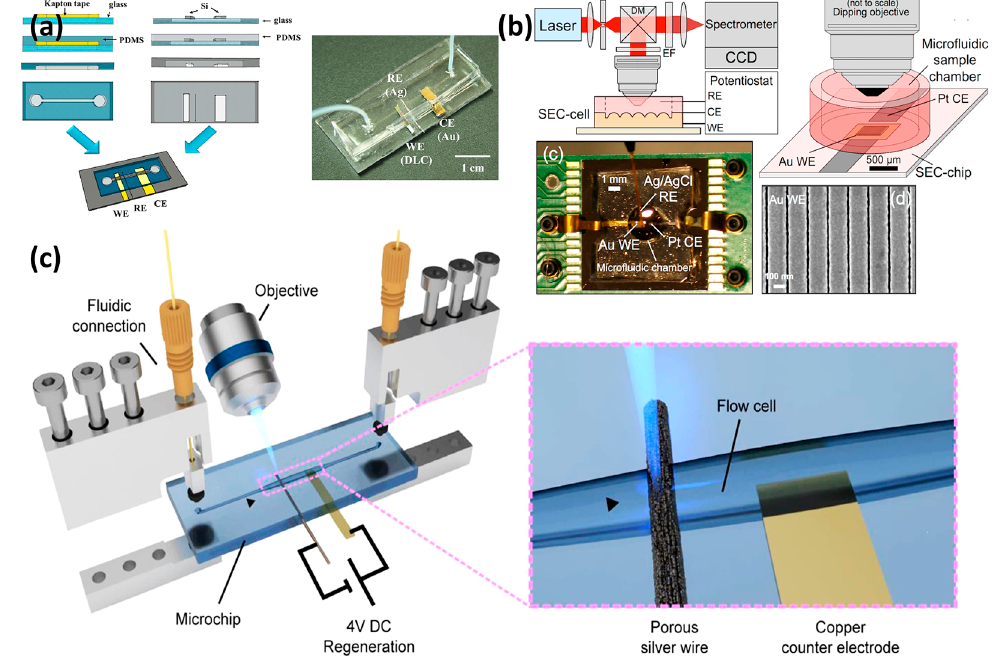
Figure 9. ( a ) Fabrication steps for a three-electrode microfluidic device. Right: The process to produce a PDMS microfluidic device with a three-electrode configuration. Left: As-assembled microfluidic device with embedded electrodes. Reprinted from [169], with permission from ACS Publications. ( b ) In situ SERS SEC analysis system. Reprinted from [93], with permission from ACS Publi- cations. ( c ) Illustration of the microfluidic setup for SERS measurements. Reprinted from [104], with permission from ACS Publications.